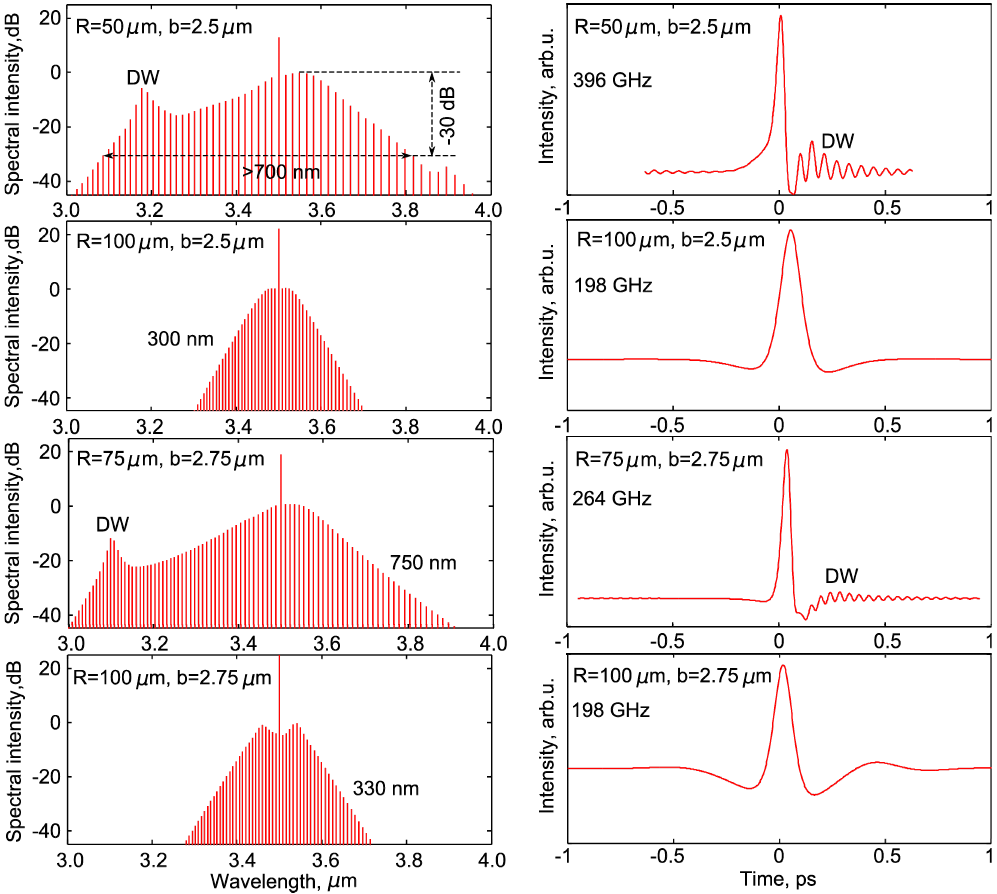
Figure 5. Spectra of optical frequency combs (left column) and temporal intensity distributions (right column). DW is dispersive waves.